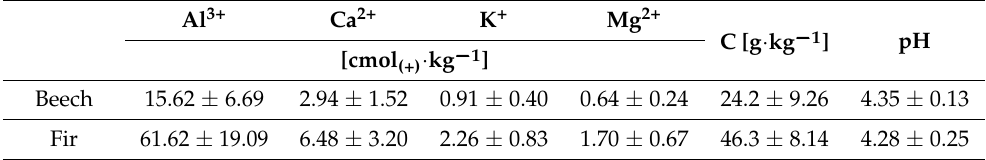
Table 1. Exchangeable cation (Al 3+ , Ca 2+ , K + , and Mg 2+ ) contents, carbon content, and pH of non-leached soils (average values ± standard error, n = 10) in soil under beech and fir